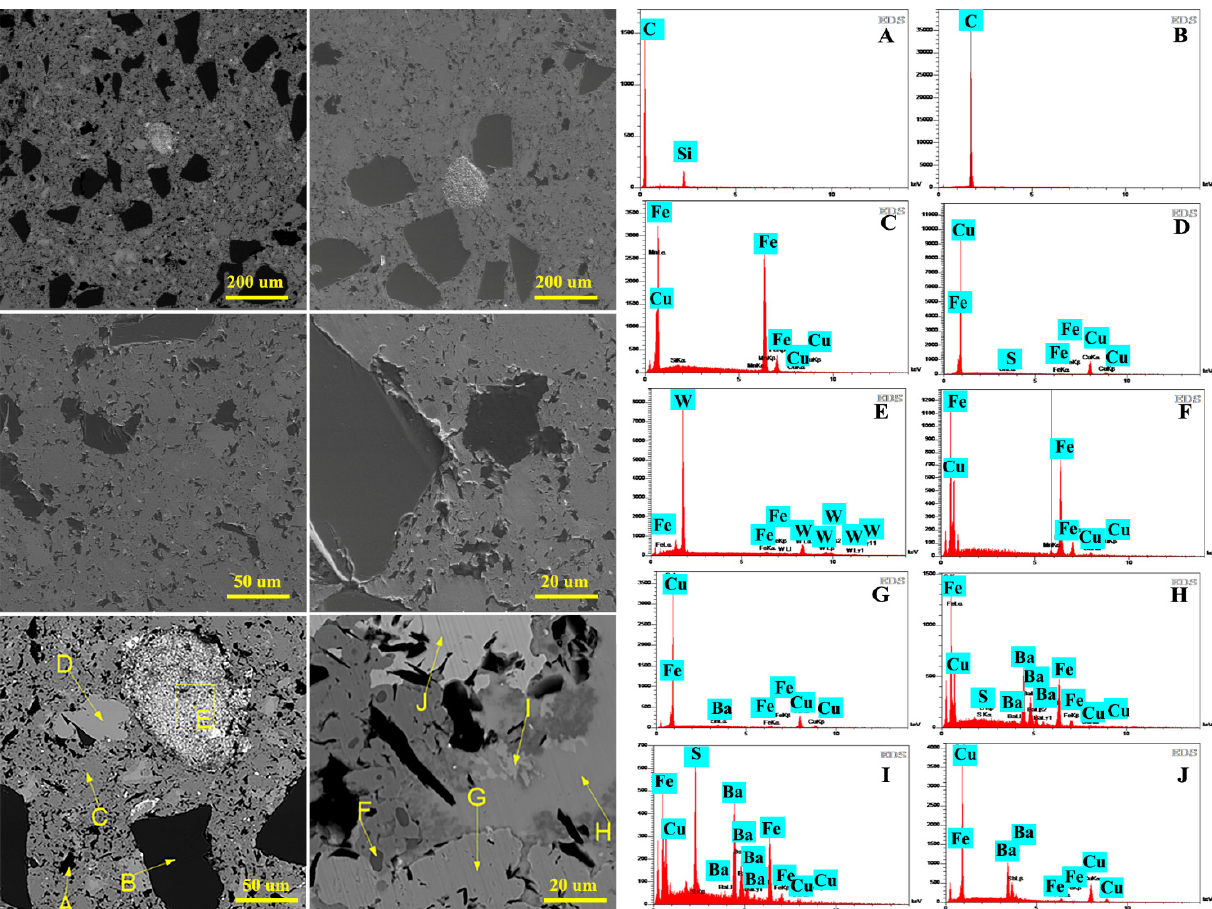
Figure 4. SEM micrographs of sample 6 and EDS analysis of different phases.